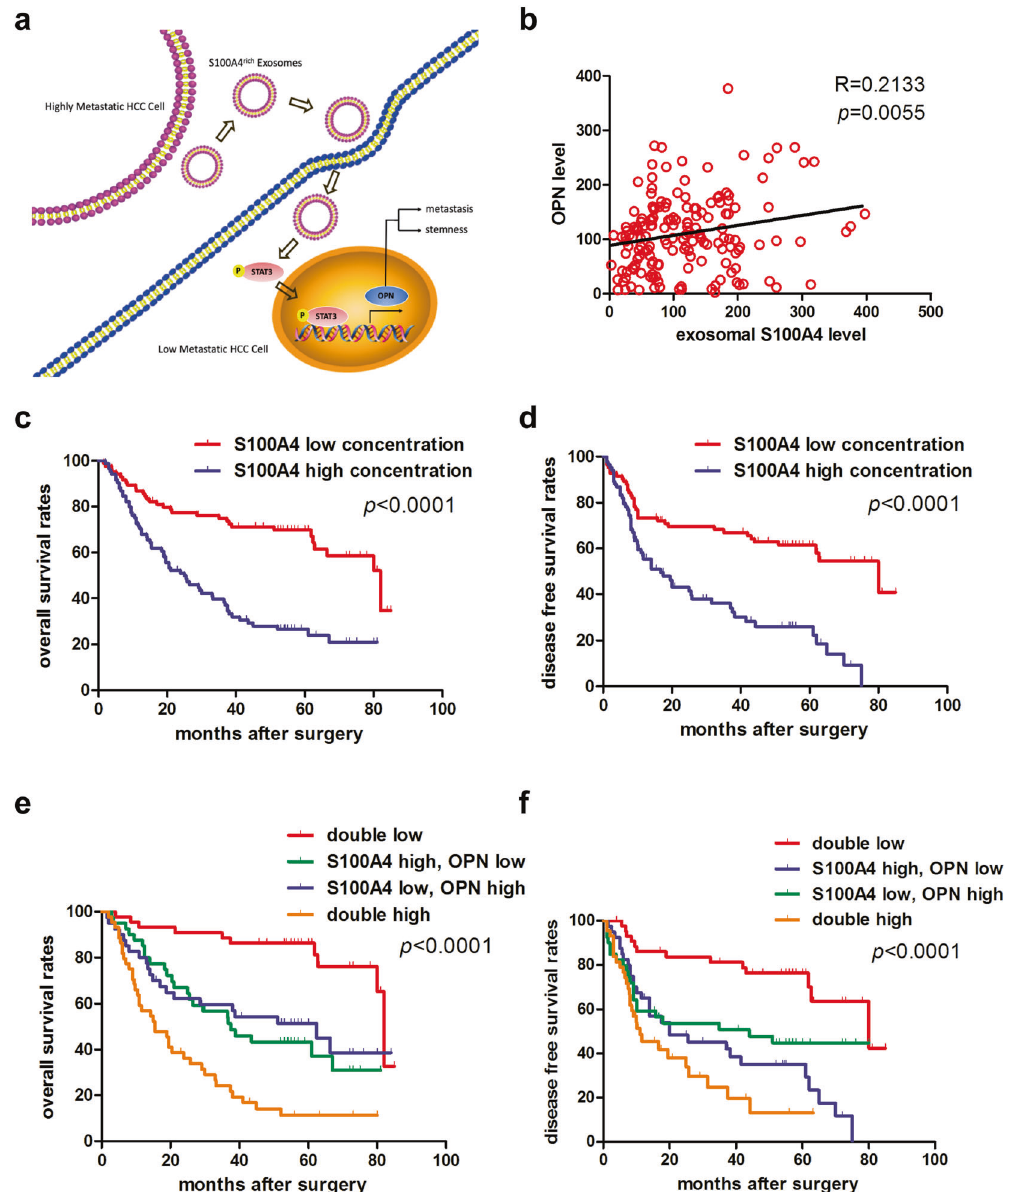
Fig. 6 Plasma exosomal S100A4 and OPN levels jointly serve as a powerful postoperative prognostic factor for HCC patients. a Working model of exosomal S100A4 promoting HCC metastasis. S100A4 rich exosomes released by highly metastatic HCC cells enhanced metastatic potential of low metastatic HCC cells via STAT3 phosphorylation and OPN up-regulation. b Correlation analysis on plasma OPN level and plasma exosomal level of S100A4 showed positive correlation in clinical samples. c , d Patients with low plasma exosomal S100A4 level had signi fi cantly better overall survival (OS) and time to treat (TTR) compared with HCC patients with high plasma exosomal S100A4 level. e , f Patients with both low plasma exosomal S100A4 level and OPN level had the longest OS and DFS among the four subgroups, which were divided according to combination of exosomal S100A4 and OPN. For each cohort, different subgroups were plotted according to the cut-off values of exosomal S100A4 (98.54pg/ml) and OPN (103.78ng/ml). Error bars represent the mean ± SD, and the dots represent the value of each experiment; * P < 0.05, ** P < 0.01, *** P < 0.001, **** P < 0.0001, ns: no signi fi cance. Simple linear regression was employed in ( b ), log-rank test was employed in ( c – f